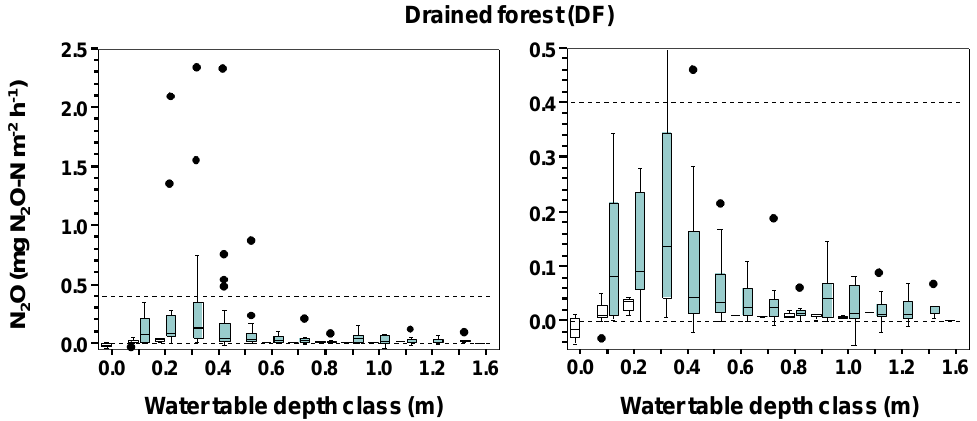
Fig. 3. Boxplot of median, quartiles and extreme N 2 O fluxes (mgN 2 O-Nm − 2 h − 1 ) at various water table depth classes (m) at the DF site. Open boxes denote fluxes for monitoring period 2000–2001 and shadowed boxes for 2004–2007. Panel on left is with scale showing all data and panel on right shows details with smaller scale (dotted lines denote scale limit of the other panel and zero flux).